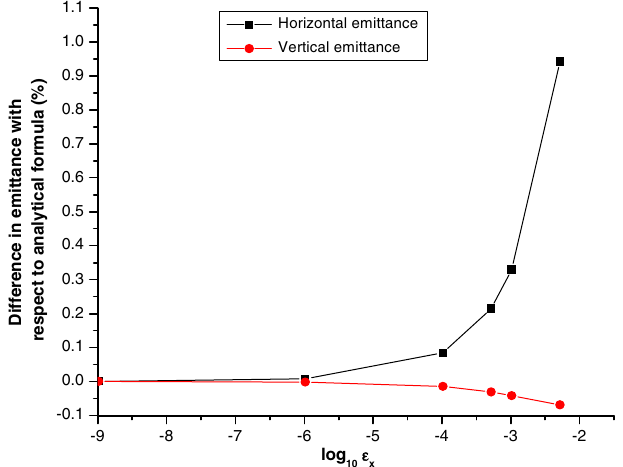
FIG. 13. Variation in difference in final horizontal and vertical emittance obtained from analytical expression and MAD as a function of initial horizontal